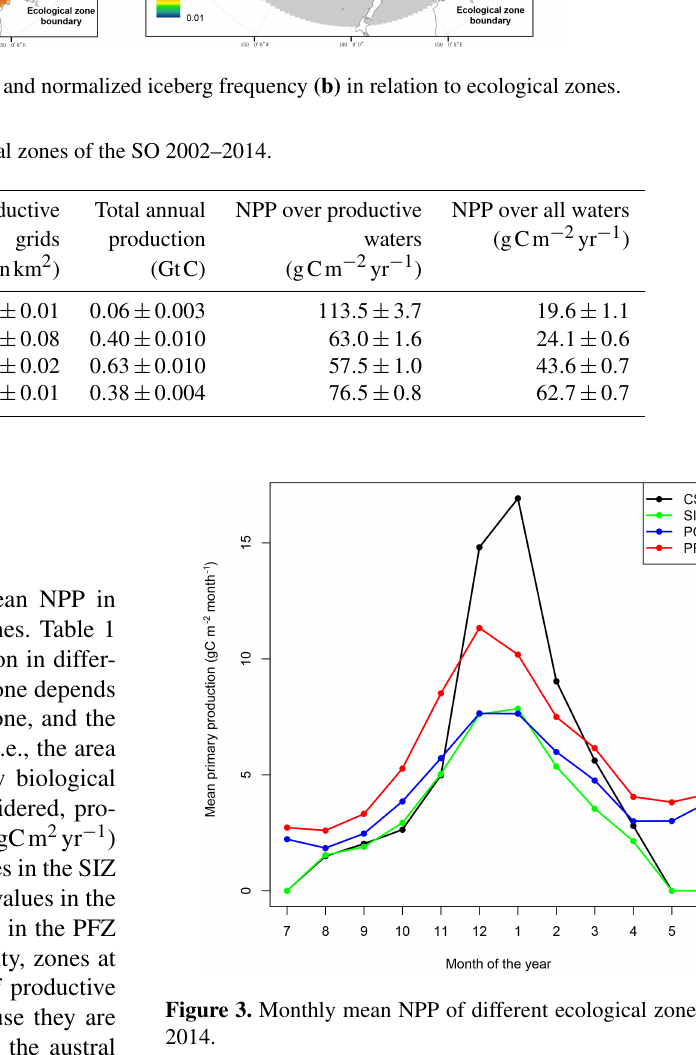
0 . 004 Gt). The CSZ contributes 0 . 06 + 0 . 003 GtC each